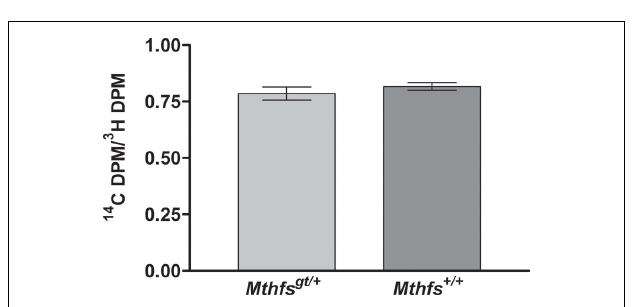
FIGURE 6 | Mthfs gt/ + mouse embryonic fibroblasts (MEFs) do not exhibit altered de novo thymidylate biosynthesis. MEFs were isolated as described in Section “Materials and methods” and cultured in the presence of [ 3 H]-thymidine and [ 14 C]-dUMP. [ 3 H]-thymidine is converted to thymidylate via the folate-independent salvage pathway, whereas [ 14 C]-dUMP is incorporated into thmidylate via the de novo pathway.The 14 C/ 3 H DPM ratio was determined in nuclear DNA from two independent cell lines for both Mthfs + / + and Mthfs gt/ + genotypes.The 14 C and 3 H content (dpm) in resulting fractions were quantified on a Beckman Coulter LS6500 Scintillation Counter.Variation is expressed as standard deviation of the mean (two cell lines per genotype), data were analysed using a student’s t -test. dUMP, deoxyuridine monophosphate.